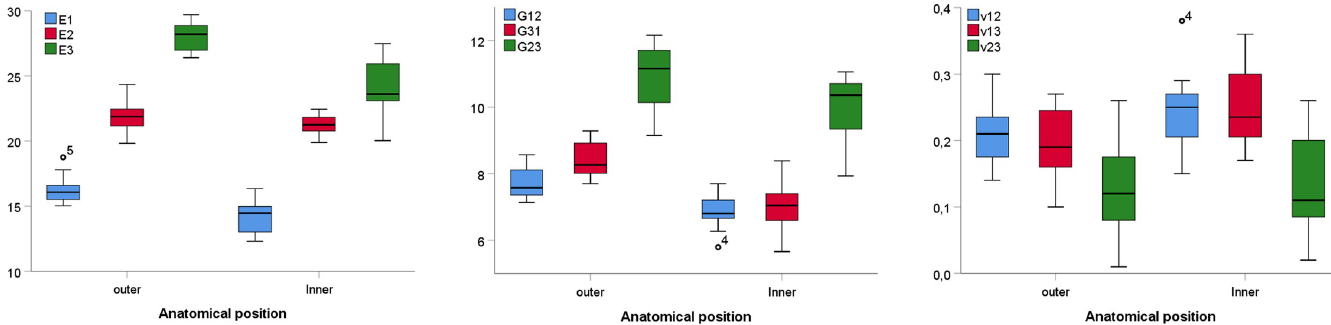
Fig 4. Principal elastic mechanical properties for baboons in the three-layered calvarial system. (A) Elastic moduli, (B) shear moduli, and (C) Poison´s ratios.